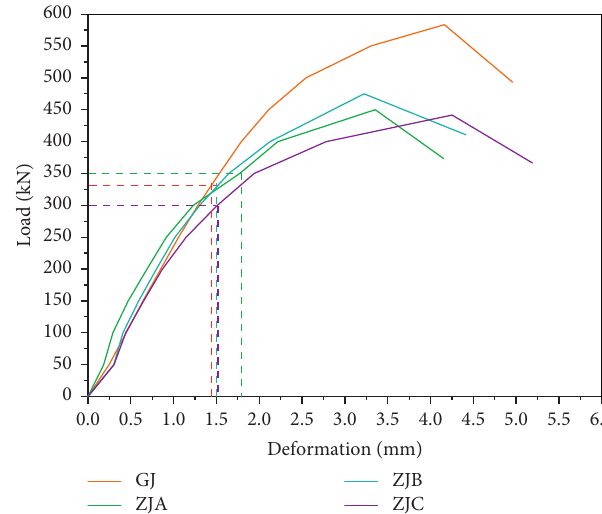
Figure 13: Axial load-axial deformation